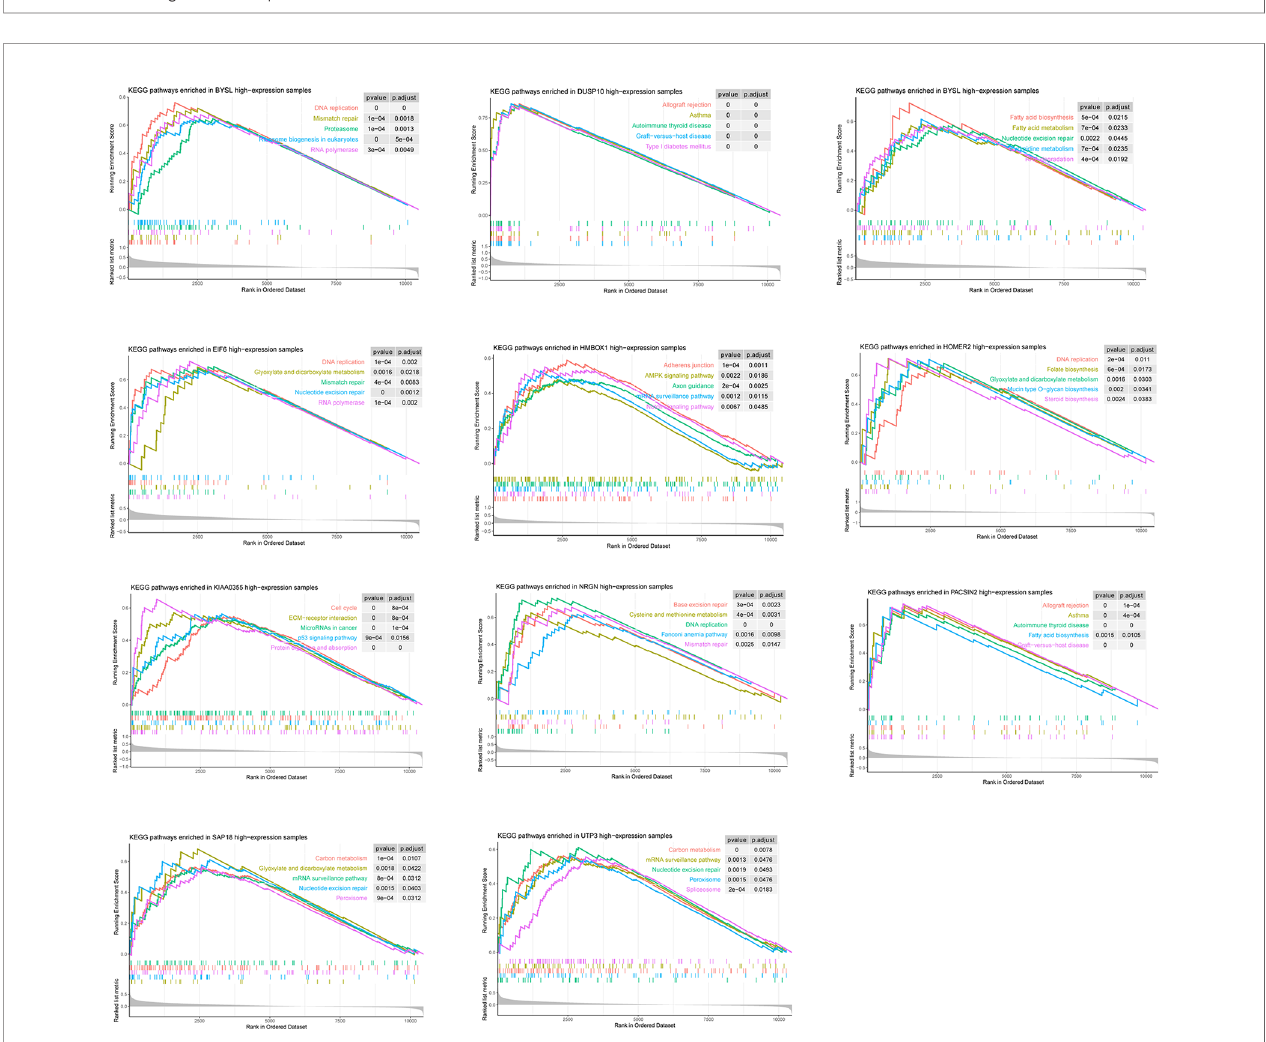
FIGURE 4 | Pathways involved in these 11 candidate